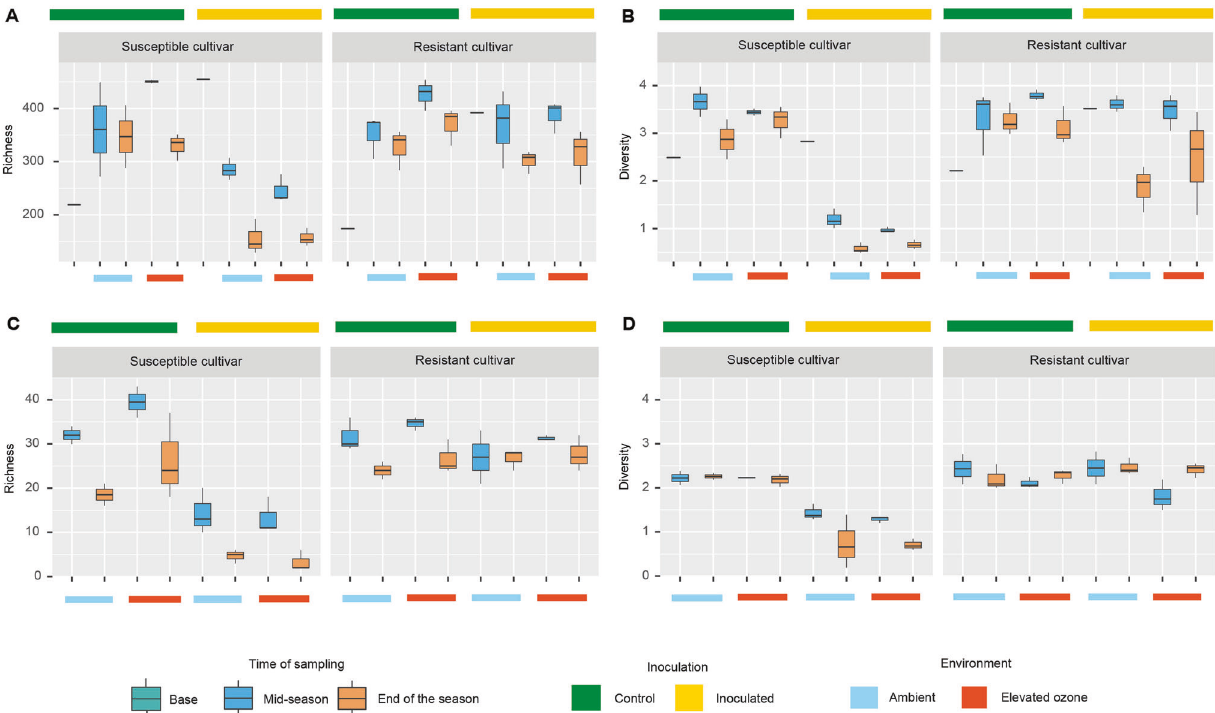
(Table S6C); end of the season: R 2 = 0.06, p = 0.19 (Table S6D,